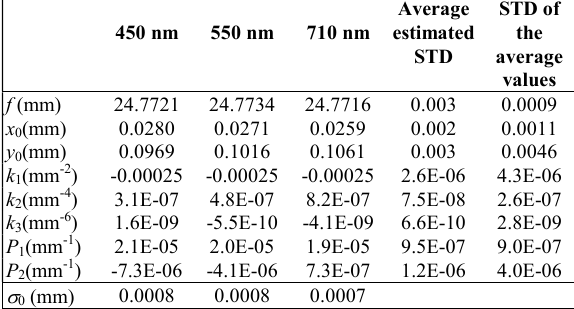
Table 4. Results obtained with the automatic cropped images: estimated values for the IOPs of images of the visible bands, average values of estimated standard deviations and standard deviations of the average values.